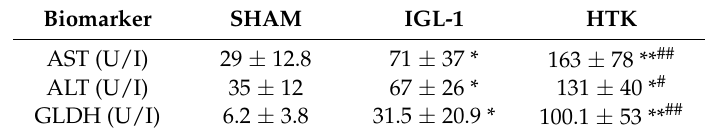
Table 1. Liver injury (measured as AST and ALT) and mitochondrial damage (measured as GLDH). Biomarker SHAM